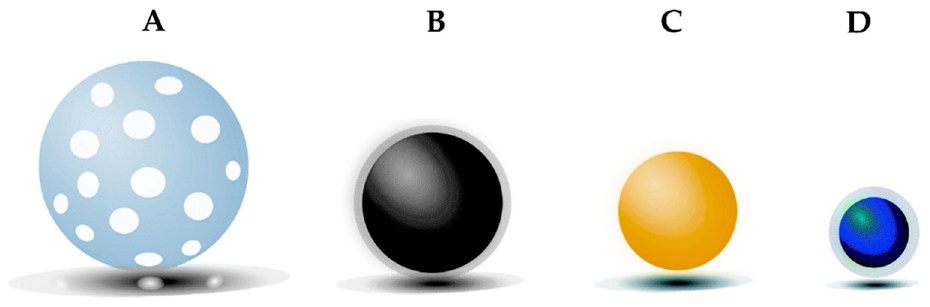
Figure 3. Main types of inorganic nanoparticles: ( A ) silica nanoparticles, ( B ) iron oxide nanoparticles, ( C ) gold nanoparticles, ( D ) quantum DOTs. Adapted from